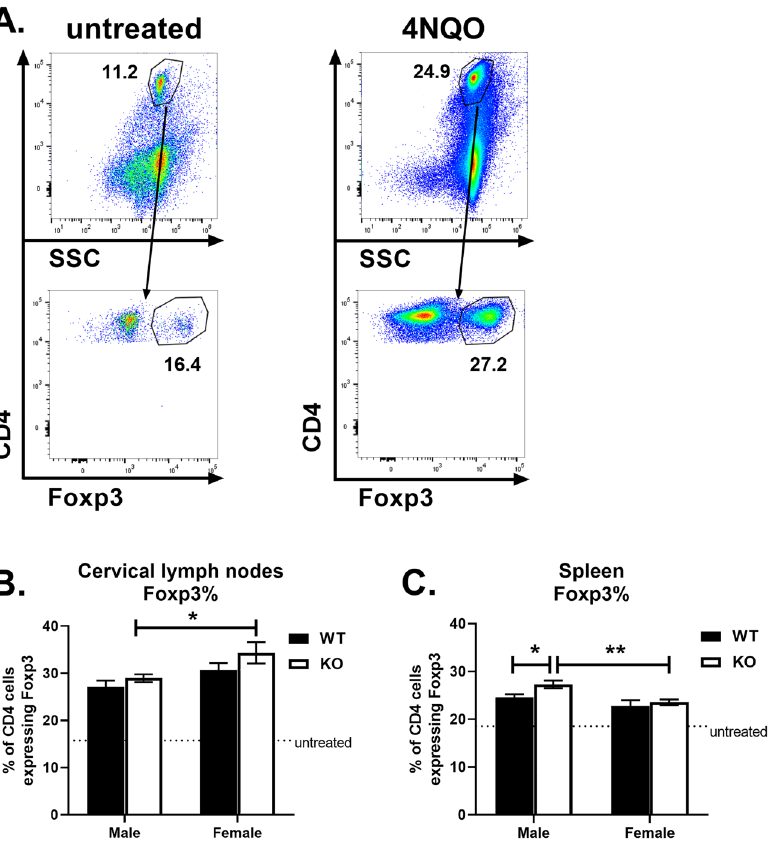
Figure 4. Role of GPR68 on Treg frequencies following 4NQO treatment. Single cell suspensions from cervical lymph nodes and spleen were stained for CD4 and Foxp3, and analyzed by flow cytometry. ( A ) Representative dot plots showing SSC vs. CD4 (top) and Foxp3 versus CD4 (bottom) from cervical lymph nodes of untreated and 4NQO-treated mice on week 24. ( B ) Mean +/− SEM of the percent of CD4 T cells expressing Foxp3 in cervical lymph nodes of WT (closed symbols) and KO mice (open symbols), as indicated. The dotted line represents Foxp3 frequencies in age-matched untreated mice. ( C ) Mean + /- SEM of the percent of CD4 T cells expressing Foxp3 in spleen of WT and KO mice, as indicated. Data are from the same experiments described in Fig.